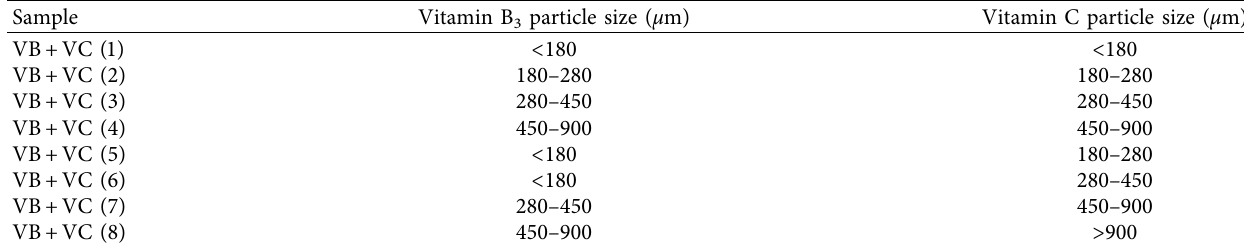
Table 1: Particle size range of each component in the vitamin mixture. Sample